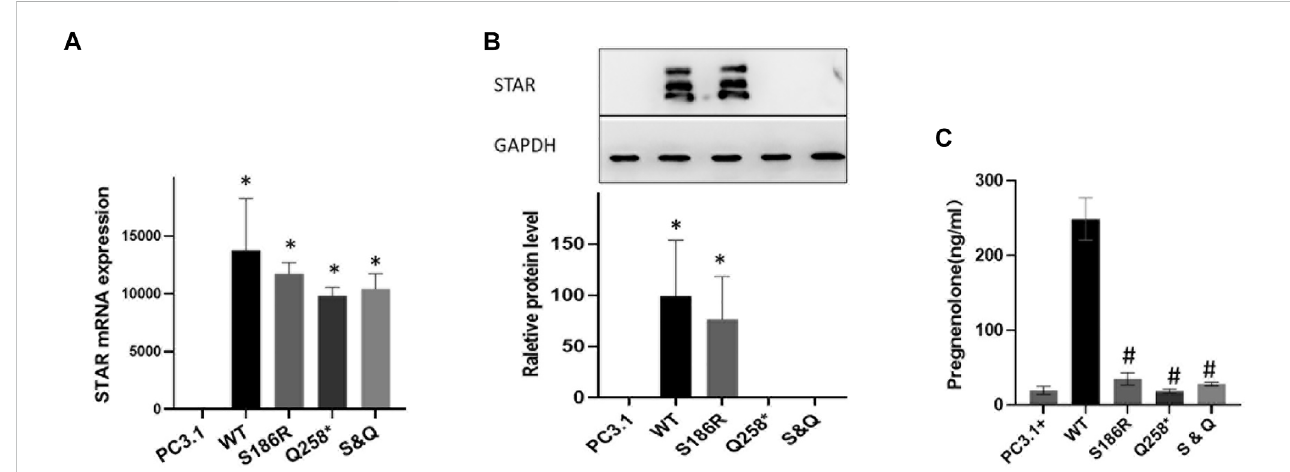
FIGURE 3 Functional analysis of the STAR mutation in vitro . (A) STAR mRNA expression of the mutant Q258*, S186R, and Q258*/S186R was similar to wild-type STAR but higher than theempty plasmid vector. (B) The protein expressionof the mutant S186R was similar to that of the wild-type STAR but greater than the empty plasmid vector. The mutant p. Q258* and Gln258X/S186R were too low to detect. (C) Progesterone expression: mutation Q258*, S186R, and Q258*/ S186R compared with the wild-type signi fi cantly reduced after cholesterol stimulation * p < 0.05 vs empty pcDNA3.1 plasmid; # p < 0.05 vs pcDNA3.1- WT-STAR